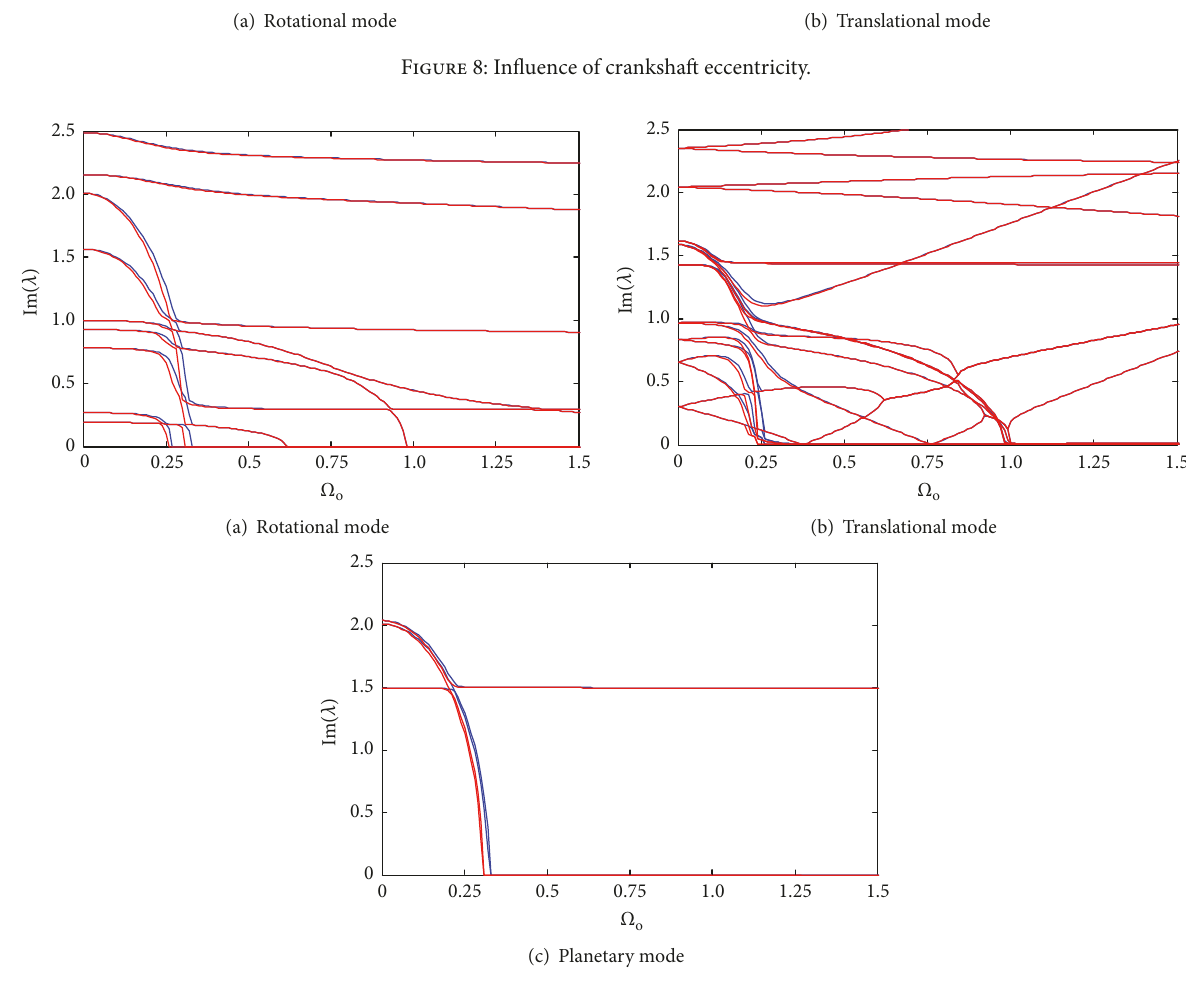
Figure 9: Influence of number of